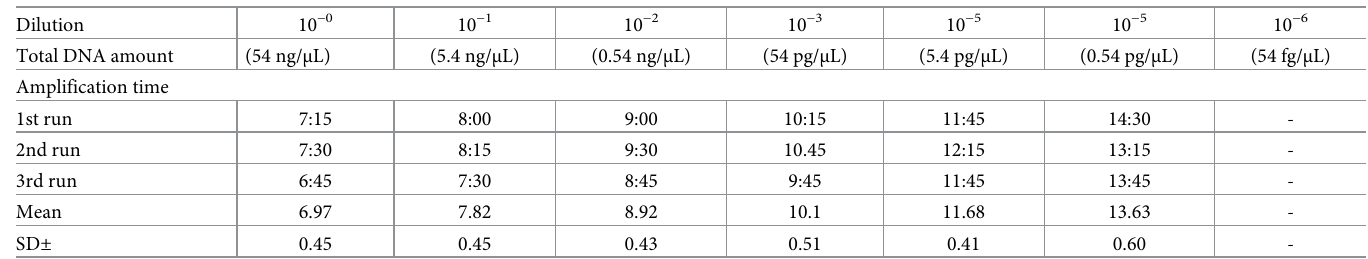
Table 3. Analytical sensitivity of the LAMP assay using serial dilutions of Thunnus albacares DNA. Dilution 10 −